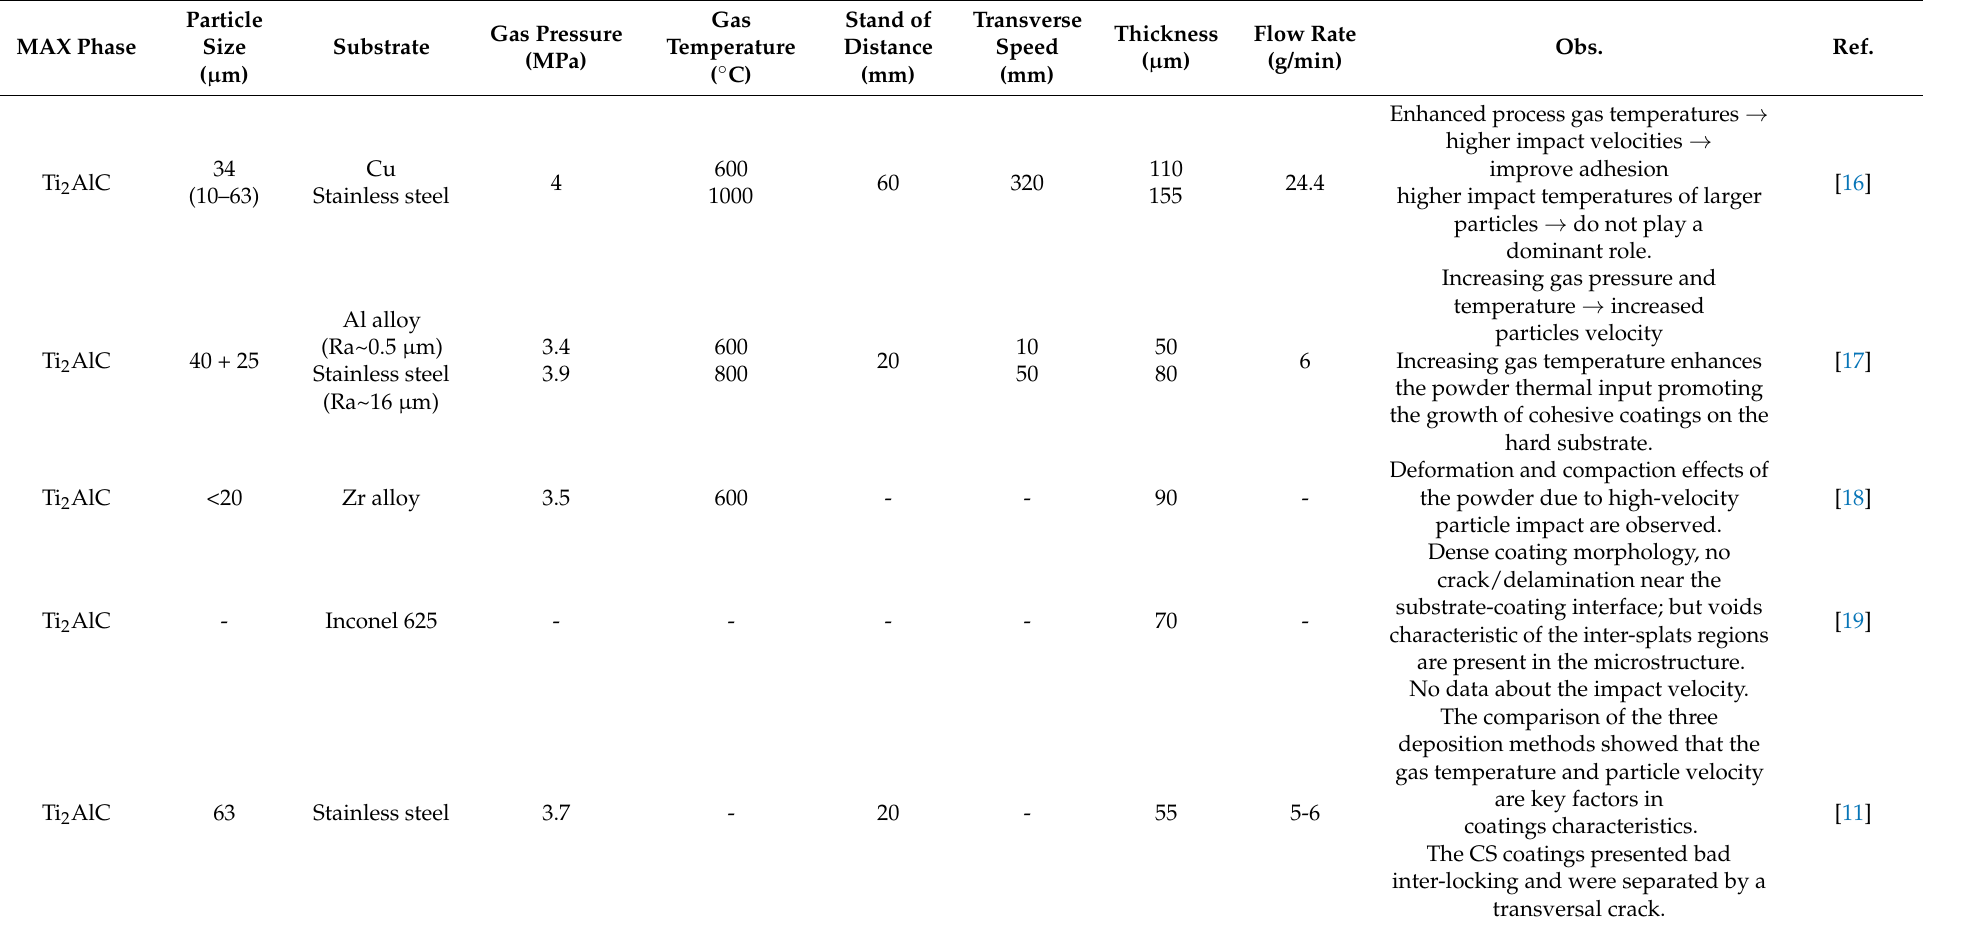
Table 3. Experimental parameters of different MAX phase compounds CS deposition as reported in the up-to-date